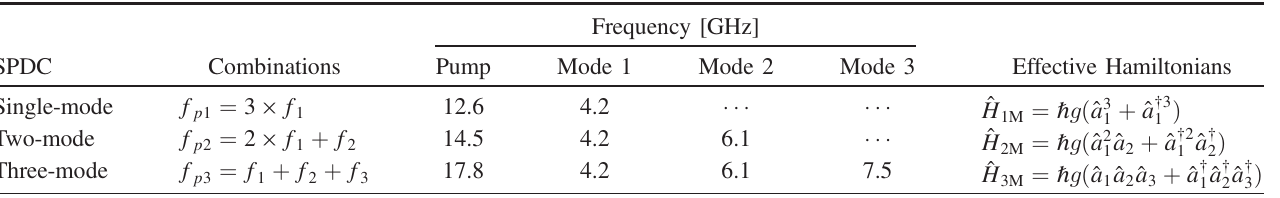
TABLE I. Cubic SPDC Hamiltonians explored in this work. Each row represents a distinct process and individual experiment, where we pump the SQUID at the specified frequency, driving three-photon down-conversion to one, two, or three cavity modes. We choose which Hamiltonian to explore simply by setting the pump